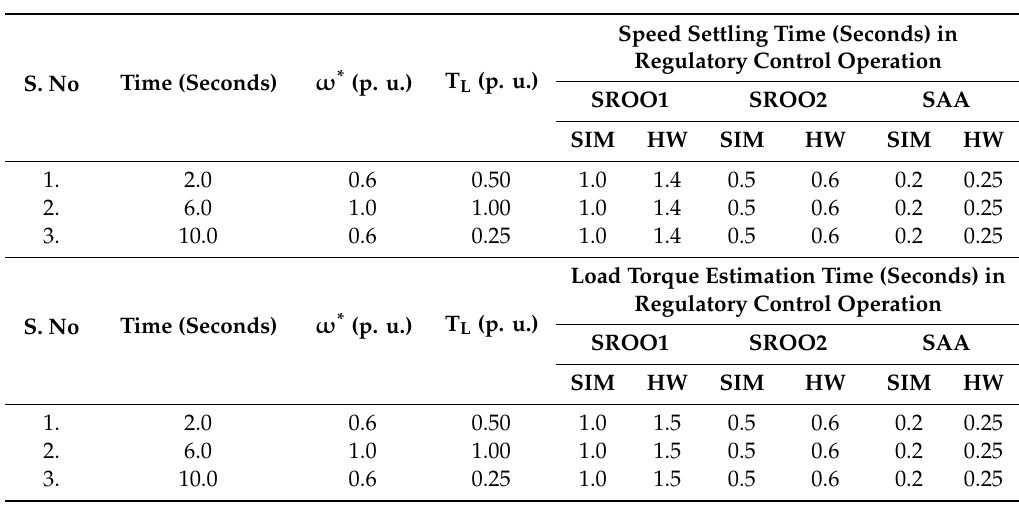
Table 2. Comparison between SAA and SROO: constant load torque/Luo converter with dynamic load.